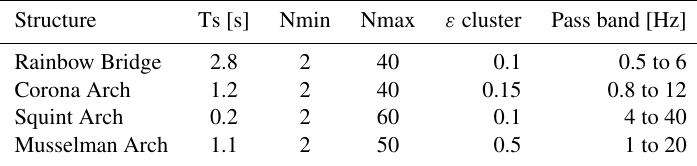
Table A1. SSI-COV input parameters as defined by Cheynet (2020). Ts: time lag for covariance calculation (2 to 6 times the natural period), Nmin: minimal number of model order, Nmax: maximum number of model order, ε cluster: maximal distance inside each cluster. Frequency accuracy ( ε frequency), MAC accuracy ( ε MAC), and damping accuracy ( ε zeta) are set to 0.01, 0.05, and 0.04 for all analyses, respectively. The band-pass filter was chosen such that the resonant peaks observed in the spectra are included. Nmax and ε cluster were tested in a trial-and-error approach to obtain stable poles that match the first three observed resonant modes.